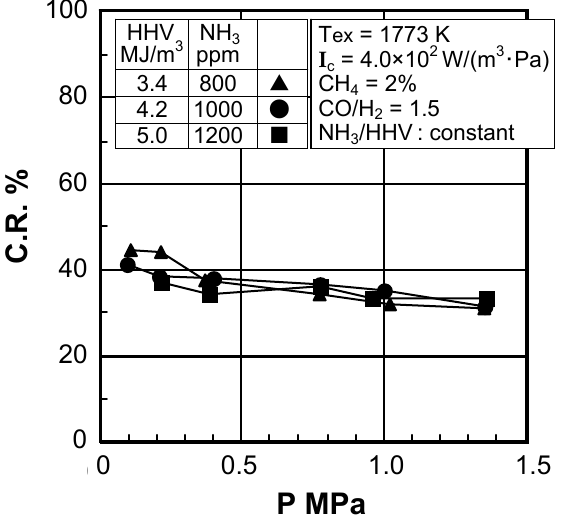
Figure 58. Influence of combustion pressure on conversion rate of NH concentration as parameters. calorific value and NH 3